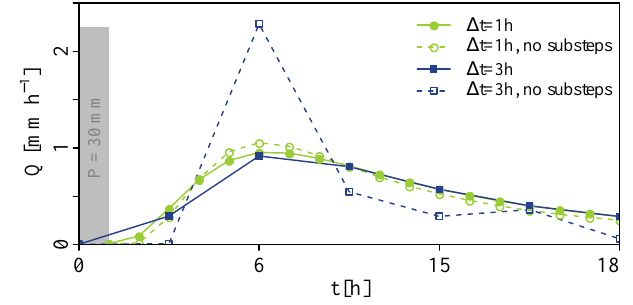
Figure 10. Illustration of the variable time step procedure. (a) The non-equidistant output time steps (purple) are used as first attempts for computations of fluxes (blue/green) and states (purple), but dur- ing time step number 3, the precipitation sum is too large (panel b ) and the step is divided into substeps: it is halved and then halved again until the criterion was reached. Note that even though the size of output time step 2 is larger, it is not divided into substeps, because all criteria are met.